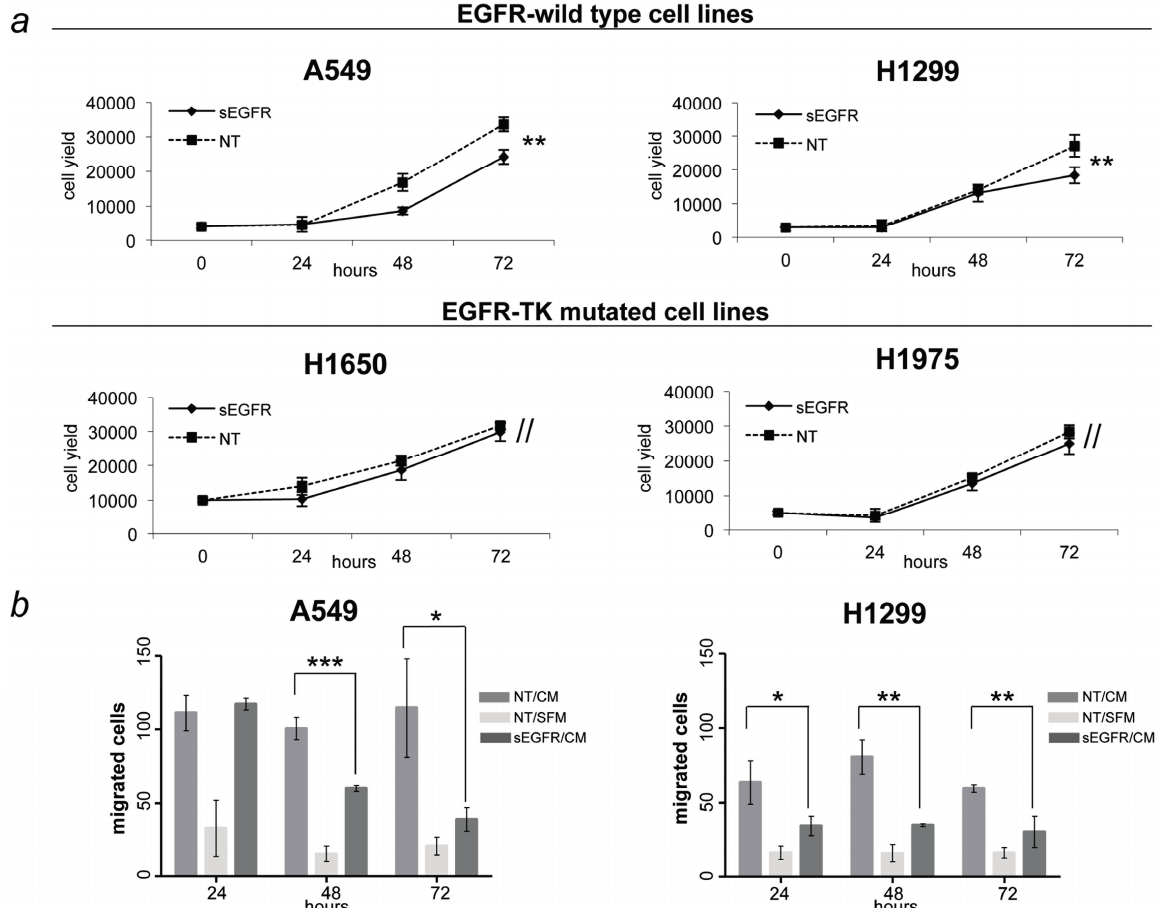
Figure 2. Effects of sEGFR on tumor cell growth and migration. ( a ) A549, H1299, H1650, and H1975 cell lines were exposed to sEGFR (1 µg/mL) or to the vehicle alone and cell counted over time; ( b ) A549 and H1299 cell lines were seeded into the upper compartment of Boyden chambers after 24, 48, and 72 h of pretreatment with sEGFR (1 µg/mL). Complete medium containing FBS 10% (CM) were placed in the lower compartment as a chemoattractant. After six hours of incubation, cells on the upper side of the filter were removed, and cells that migrated to the lower surface were fixed, stained, and counted. Serum-free medium (SFM) was used as negative control. Asterisks indicate significant differences ( * p < 0.05, ** p < 0.01, *** p < 0.001, // p not significant) when comparing cells treated with sEGFR to those untreated (NT). Data are means ± SD from experiments with three